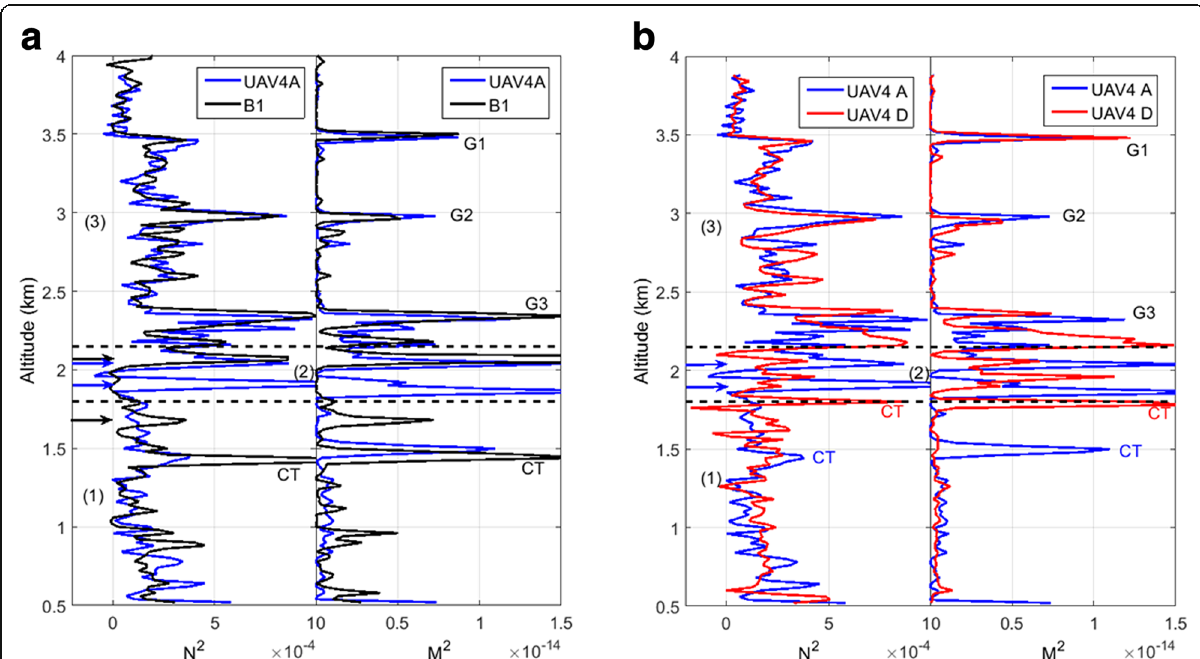
Fig. 6 a (Left) (dry) N 2 profiles at a vertical resolution of 20 m estimated from UAV4A data (blue) and B1 data (black). (Right) The corresponding M 2 profiles. The CT labels refer to the N 2 and M 2 peaks in the UAV4A- and B1-derived profiles at cloud tops. The two blue (black) arrows indicate the N 2 and M 2 peaks that may coincide with the top and bottom of KH billows crossed by UAV4A (B1). The horizontal dashed lines delineate the KH region (2). b (Left) N 2 profiles estimated from UAV4A data (blue) and UAV4D data (red). (Right) The corresponding M 2 profiles. The CT labels refer to the N 2 and M 2 peaks at cloud tops that differed by about 300 m between ascent and descent. The two blue arrows indicate the N 2 and M 2 peaks that may coincide with the top and bottom of KH billows crossed by UAV4A. The horizontal dashed lines delineate the KH region